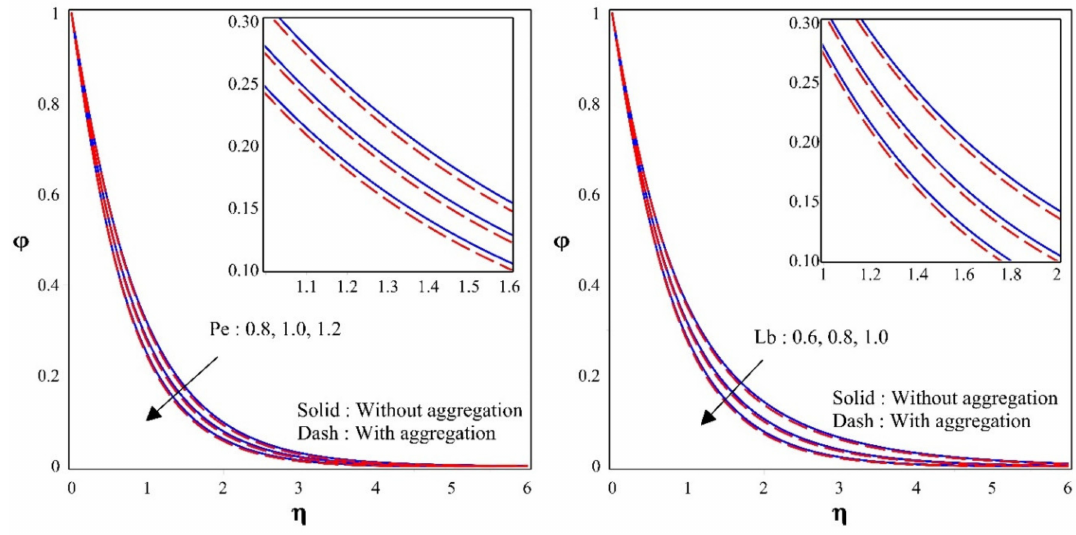
Figure 6. Sway of ϕ for different values of Pe & Lb